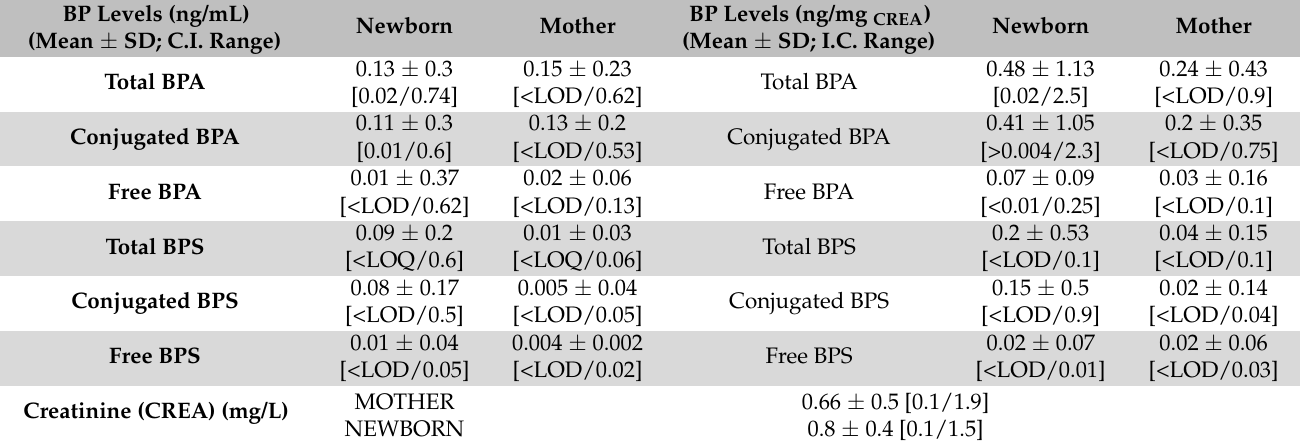
Table 3. BP levels (BPA and BPS) in the newborn and mother